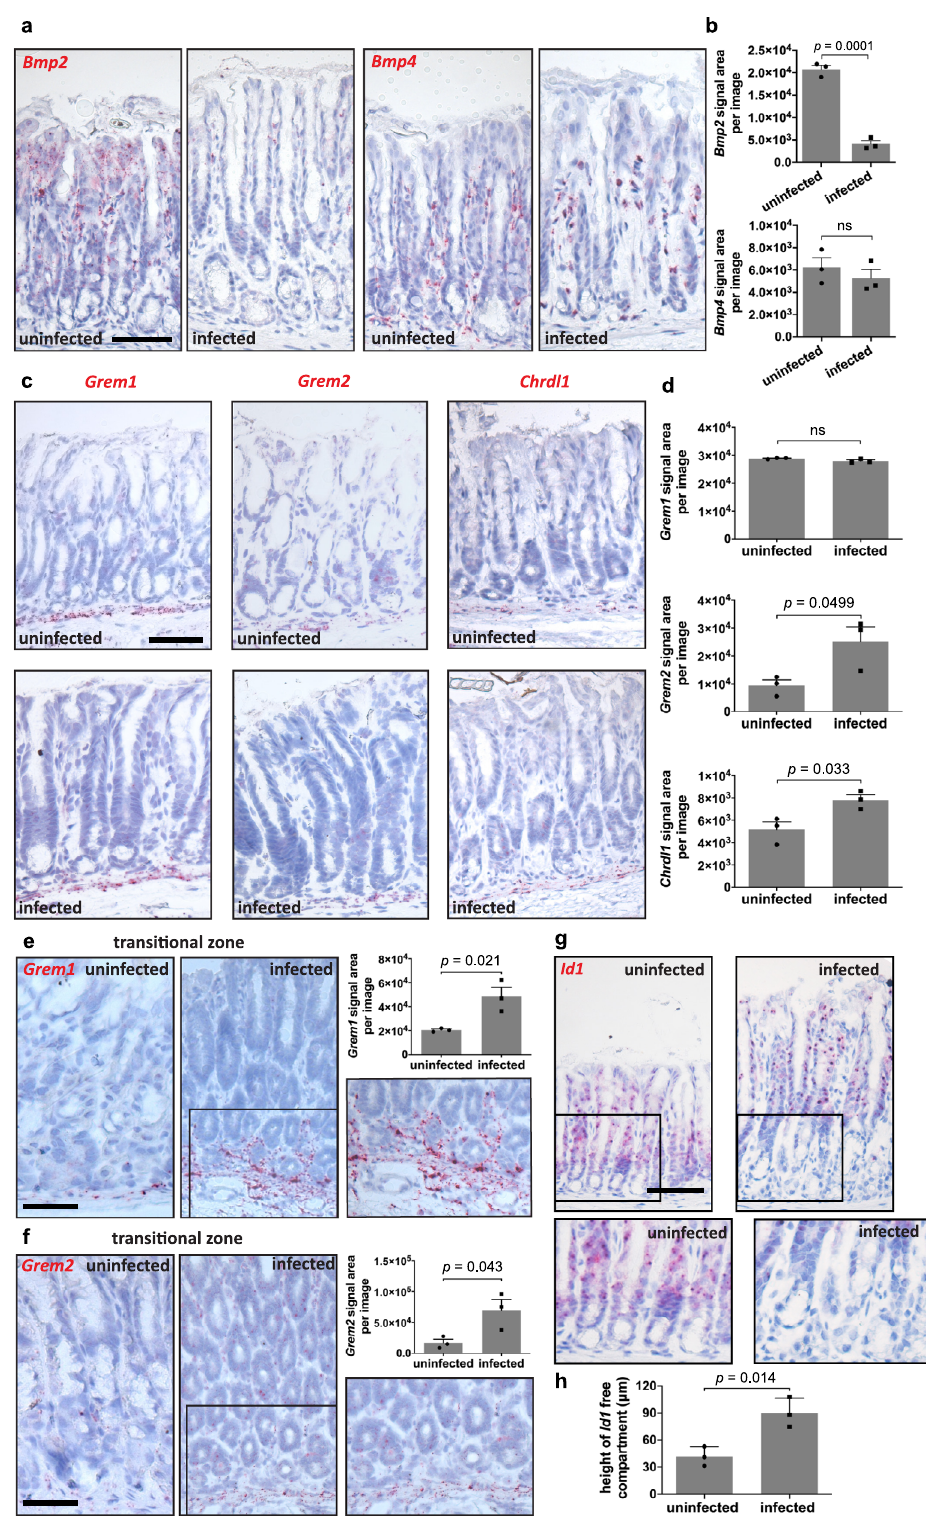
surface cells 13 . Therefore, we compared the effects of Rspo/WNT- depletion or BMP activation on epithelial stemness, proliferation, and differentiation. Treatment with BMP2 led to a more marked decrease in organoid size compared to a reduction of WNT ligand concentration or removal of Rspo from the medium (Fig.